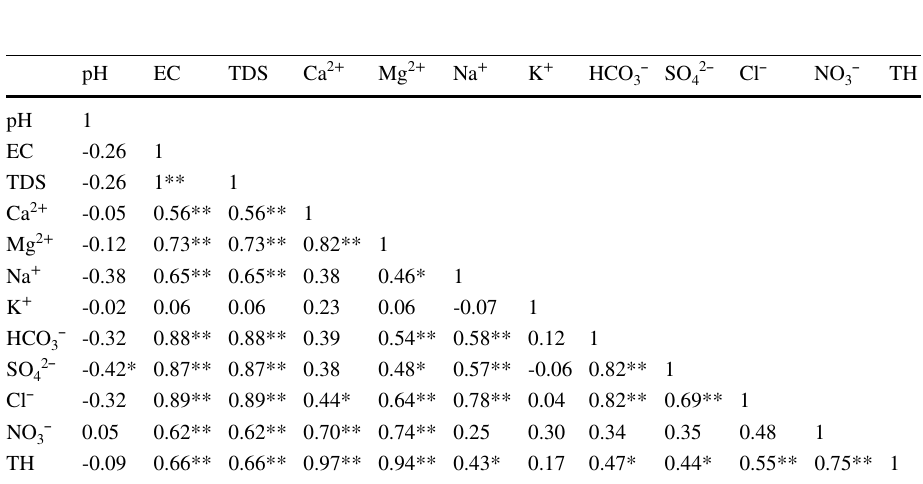
*, **Correlation is significant at the 0.05 and 0.001 level (2-tailed),